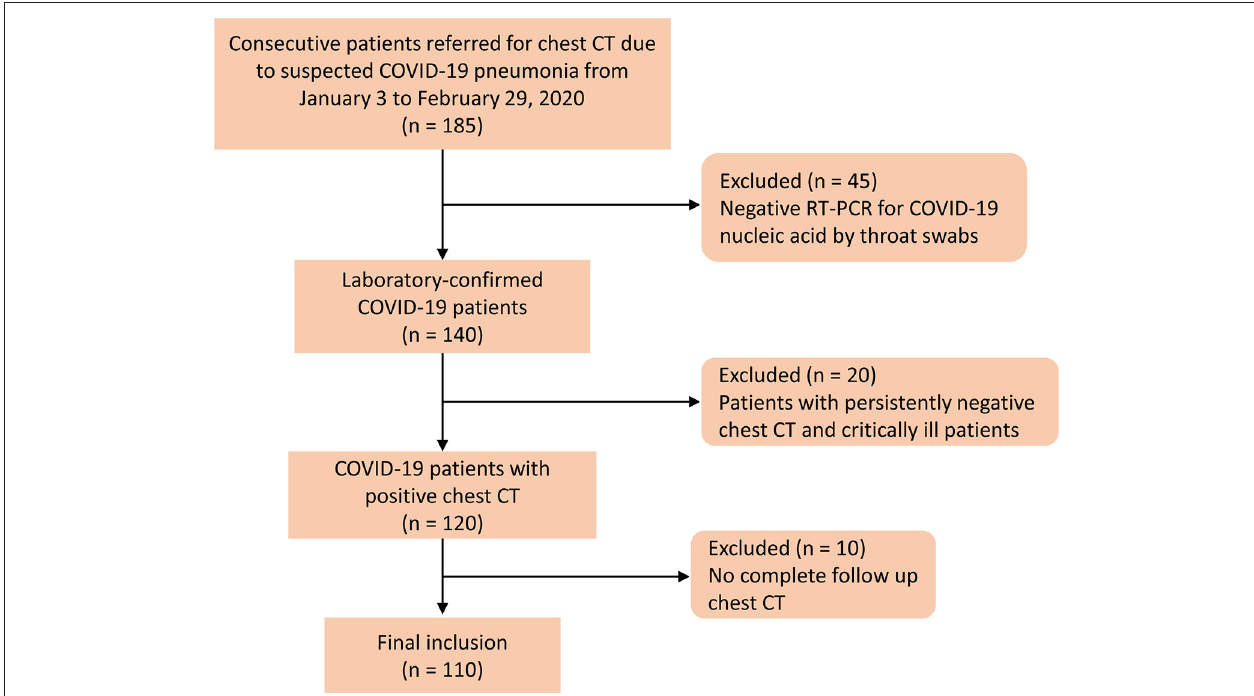
FIGURE 1 | Flow diagram of the patient selection process. Negative RT-PCR was defined as at least two repetitive negative RT-PCR test results, separated by at least 1